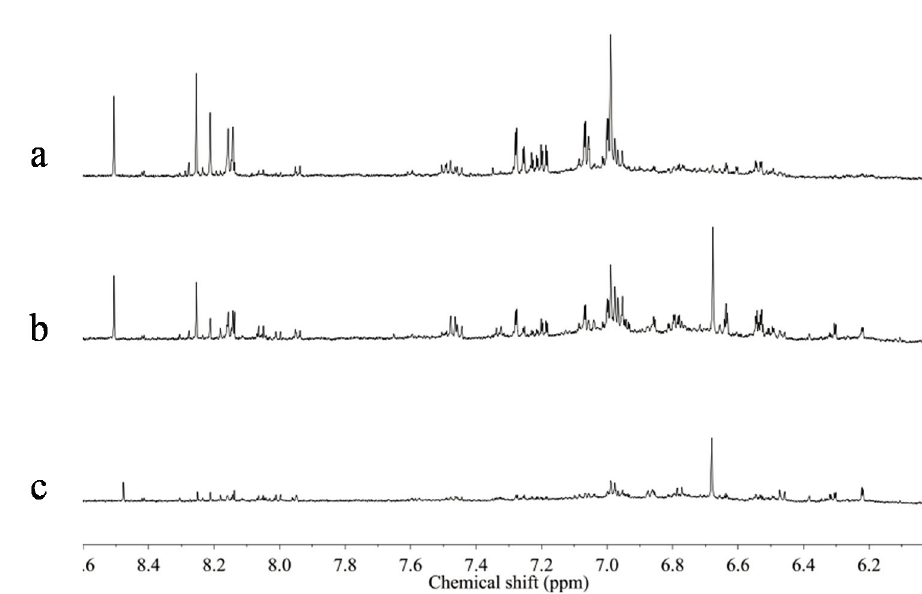
Figure 7. 1 H-NMR spectra (CD 3 OD) of 30 (a), 20 (b), and 5 years (c) old Astragalus roots collected from Shanxi province in China.